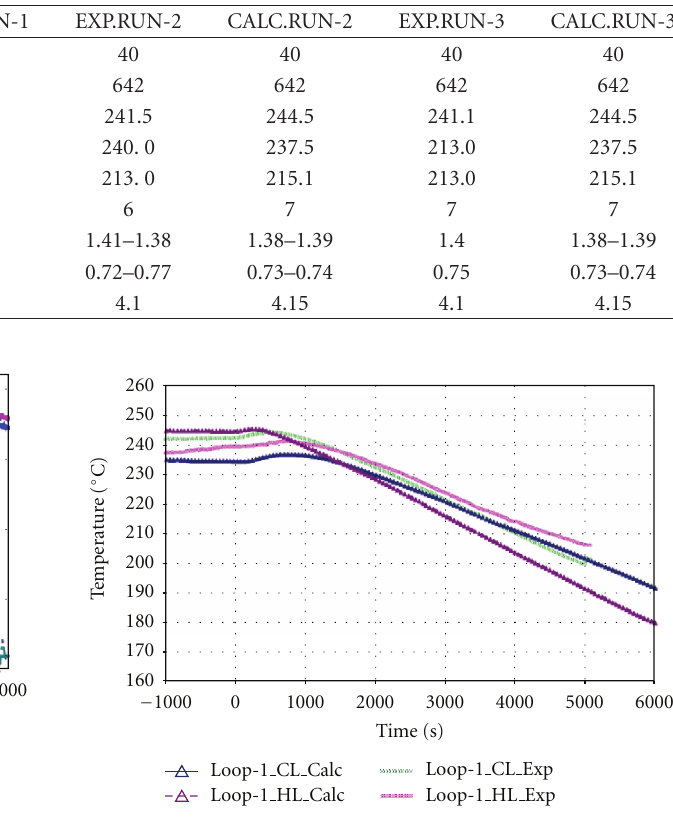
Figure 7: Run-1: Cold and hot leg temperature evolution in the active